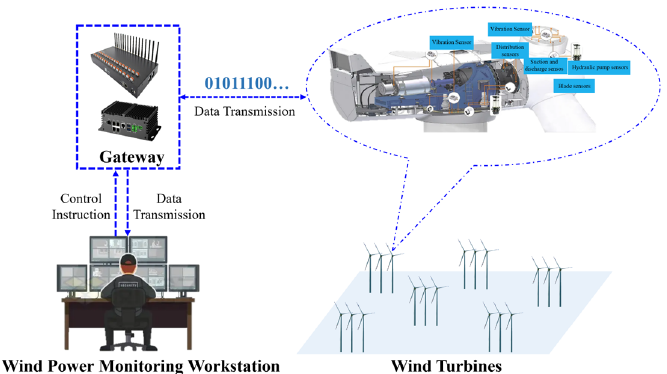
Figure 1. The information transfer process of wind turbine status sensor authentication.